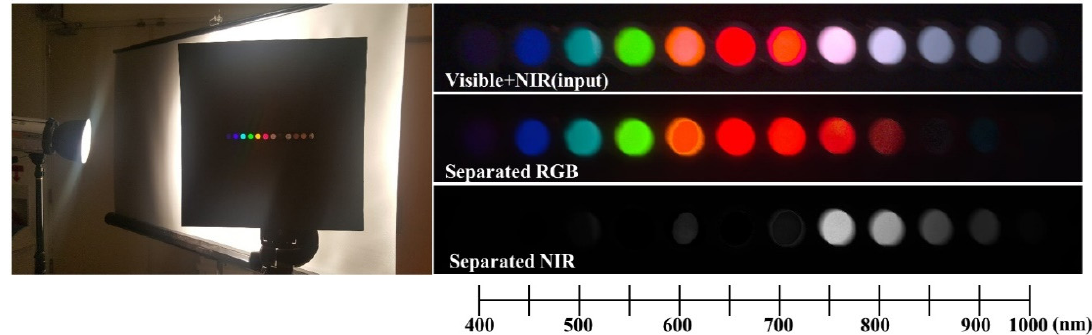
Figure 6. Experimental results of the separation of a band spectrum (bandwidth of the bandpass filters: 20 nm).